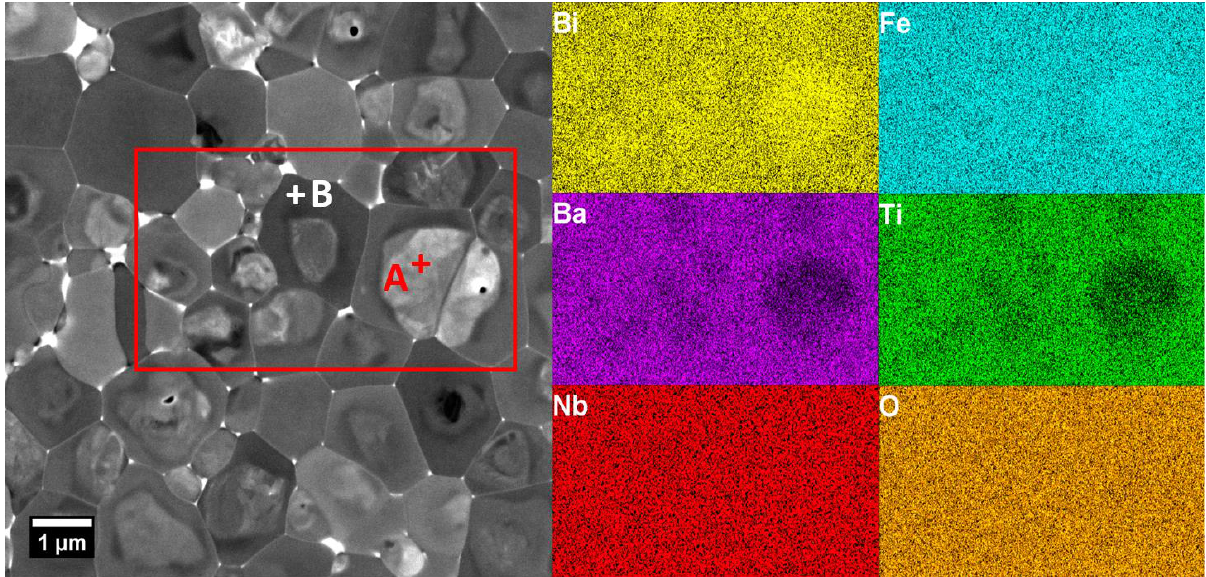
Figure 2. Scanning electron microscope images (back-scattered mode) and histograms of grain size distributions for 0.7BF – 0.3BT – xNb ceramics with ( a ) x = 0, ( b ) x = 0.005, ( c ) x = 0.01, ( d ) x = 0.02, ( e ) x = 0.03 and ( f ) x = 0.04.